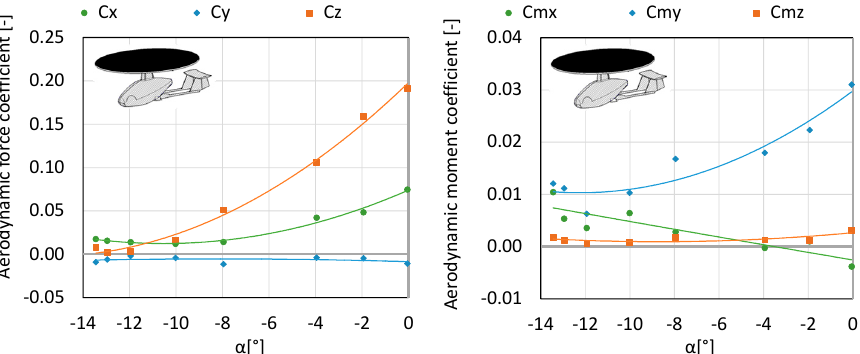
Figure 8. Characteristics of forces and moment of aerodynamic forces for configuration K3.